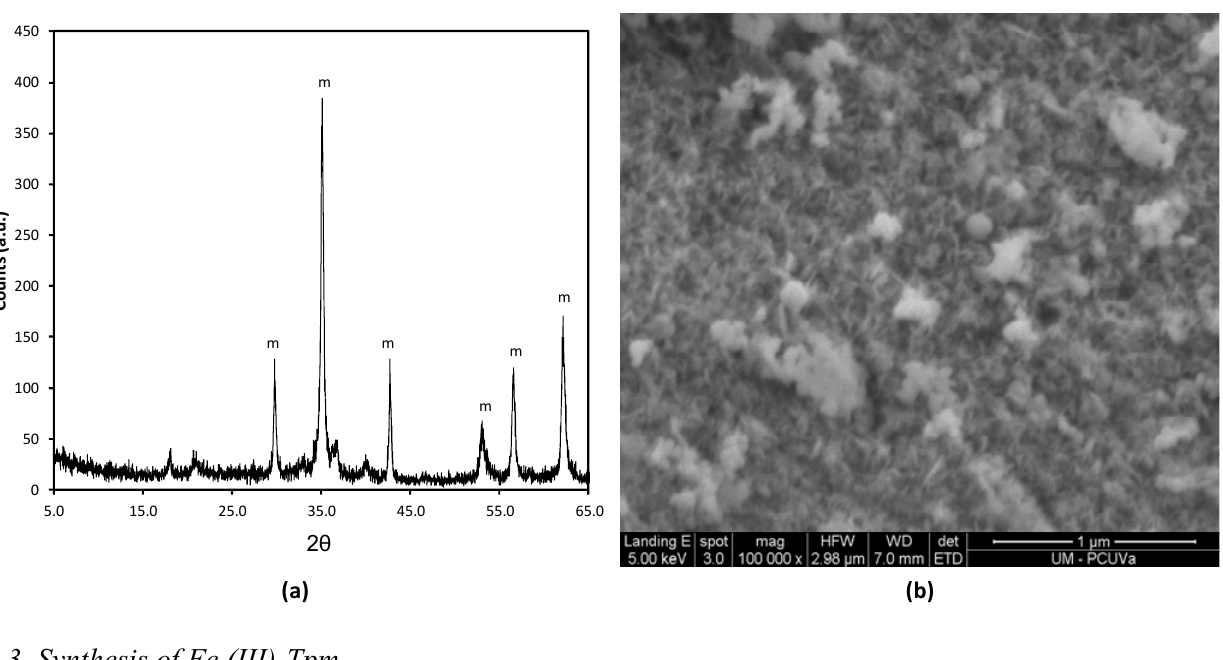
Figure 5. ( a ) Diffraction pattern and ( b ) Scanning electron microscopy image for the magnetic